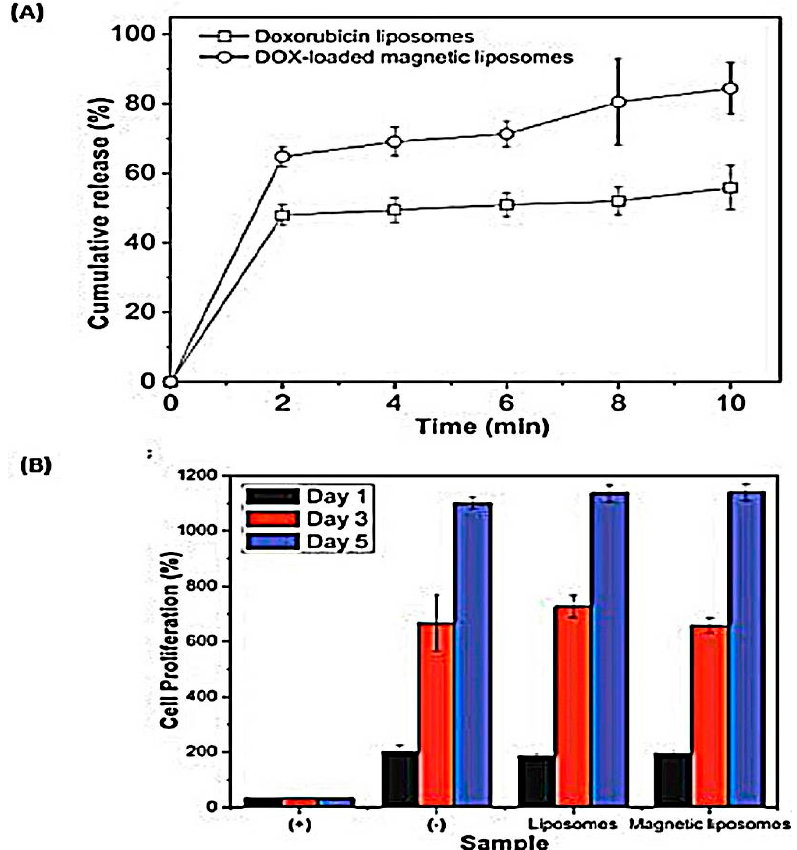
Figure 4. ( A ) Percentage cumulative release (%) of doxorubicin from doxorubicin (Dox)-liposomes and Dox-loaded magnetic liposomes with high field magnetic triggering. ( B ) The effect of different samples on cell proliferation (%) of lung fibroblast L-929 cells at 1, 3, and 5 days of incubation